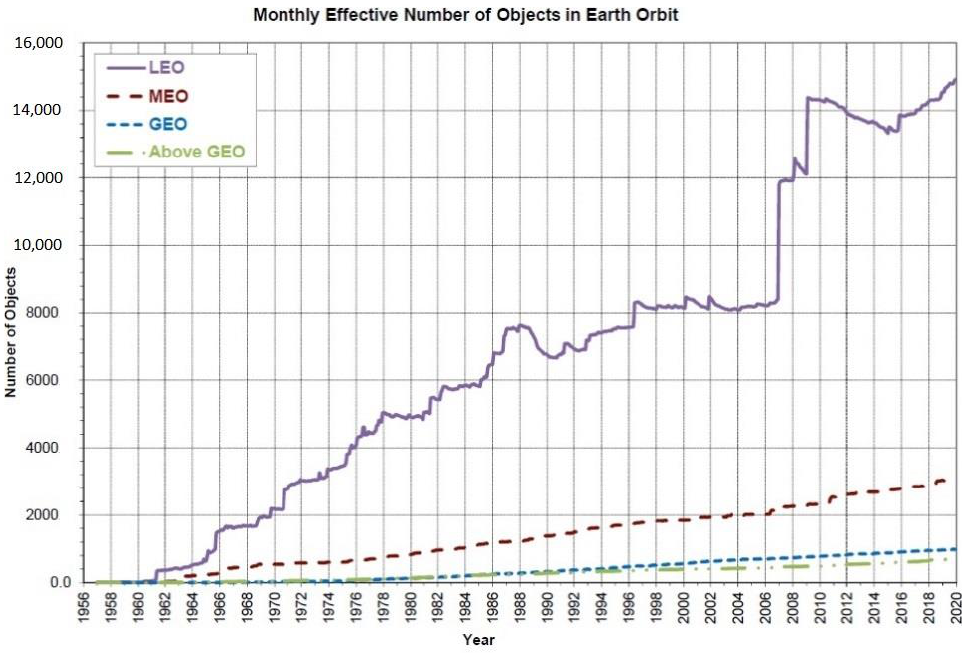
Figure 1. Monthly effective number of catalogued objects in Earth orbit by orbital regime, as cata- logued by the US Space Surveillance Network.